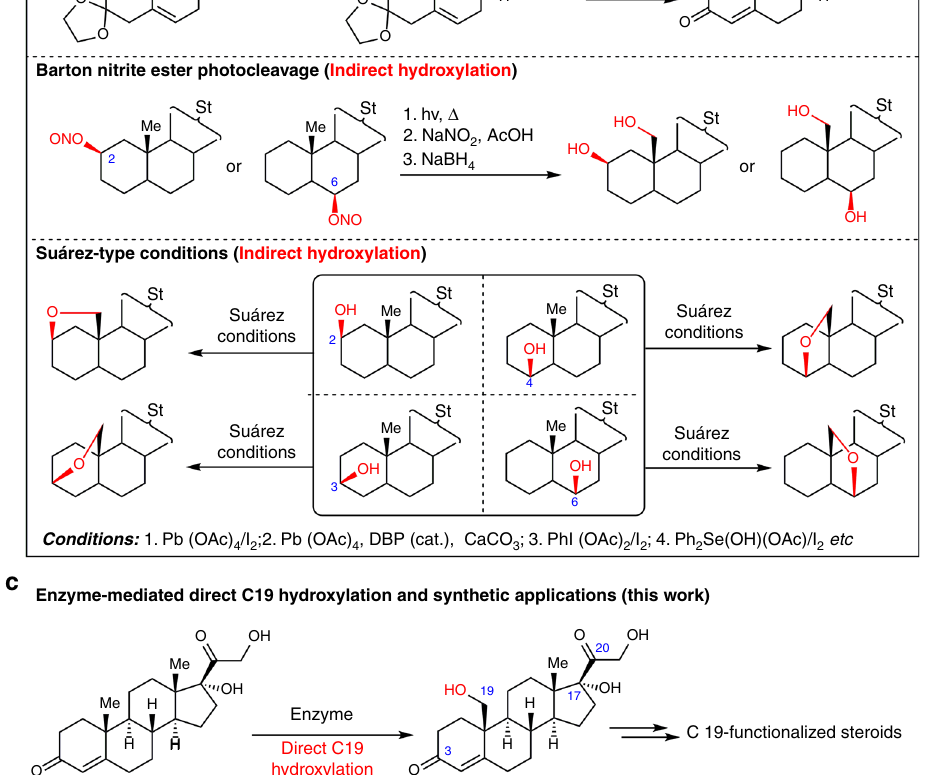
Fig. 1 Chemical and biocatalytic approache to access 19-Hydroxylated steroids. a Representative bioactive 19-hydroxylated steroids. b Chemical approaches to C19 hydroxylation of steroids. c Enzymatic C19 hydroxylation of